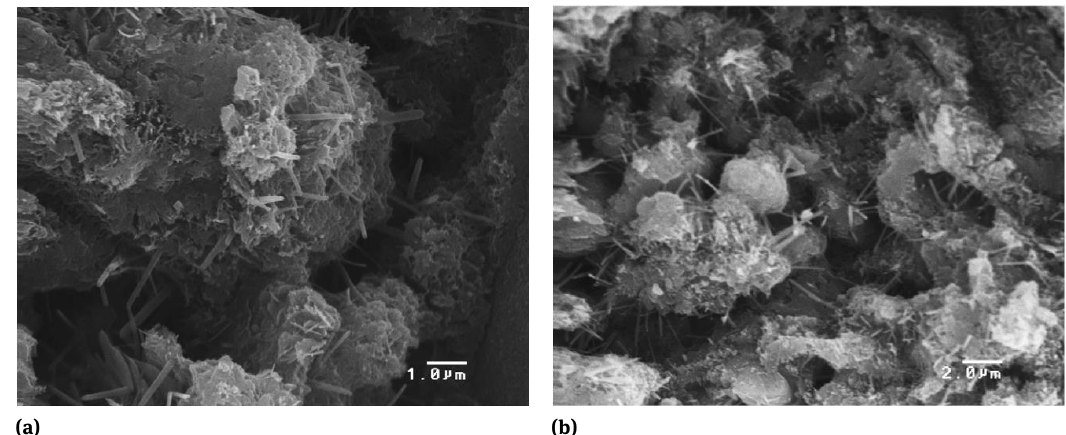
Figure 4: SEM micrographs of control group concrete: (a) 10,000 × and (b) 5000 × [102]